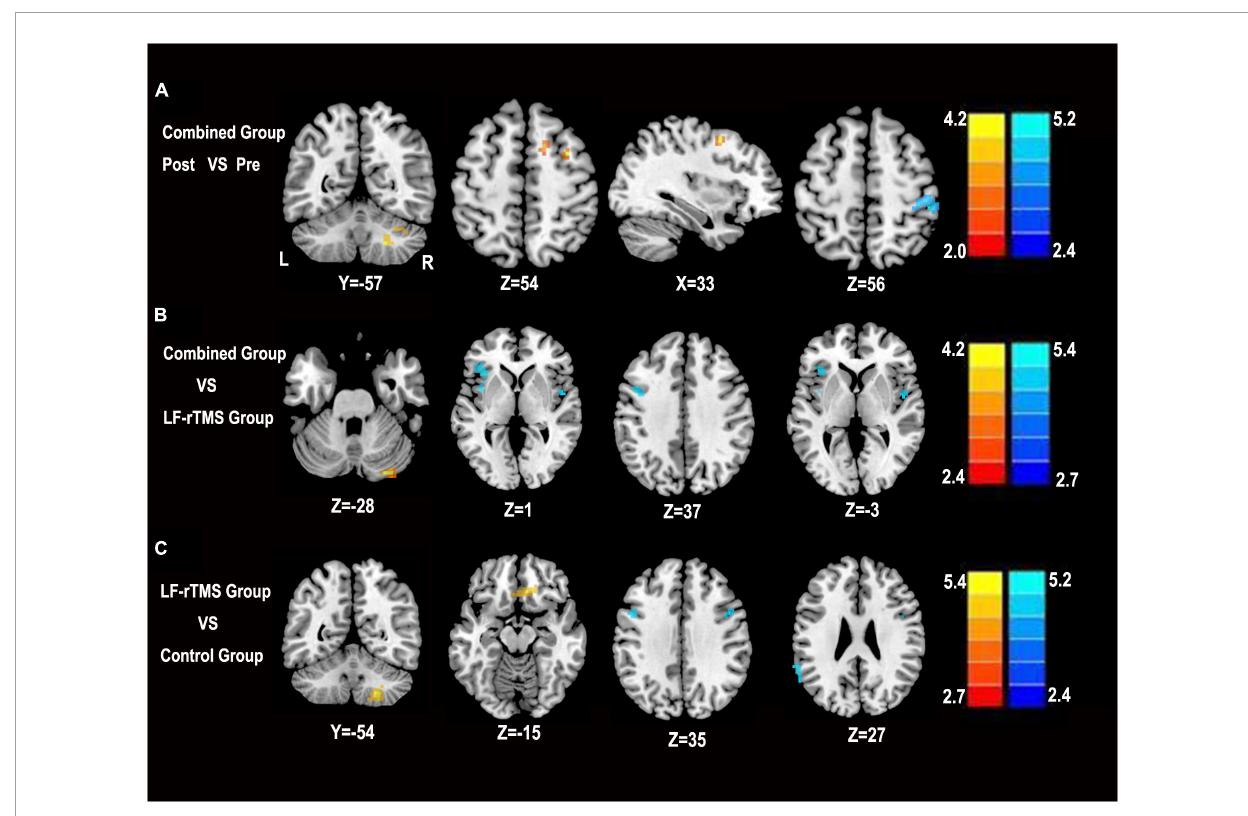
FIGURE3 Statistical parametric map showing the significant differences in ALFF among the combined group, LF-rTMS and control group. (A) Change in ALFF in the combined pre-treatment group compared with the post-treatment group. (B) Differences in ALFF between the combined group and the LF-rTMS group. (C) Differences in ALFF between the combined group and the control group. The significance level was defined at P < 0.05 with AlphaSim correction. The color bar denotes the t -value. R, right; L, left, Pre, pre-treatment in the combined group; Post, post-treatment in the combined